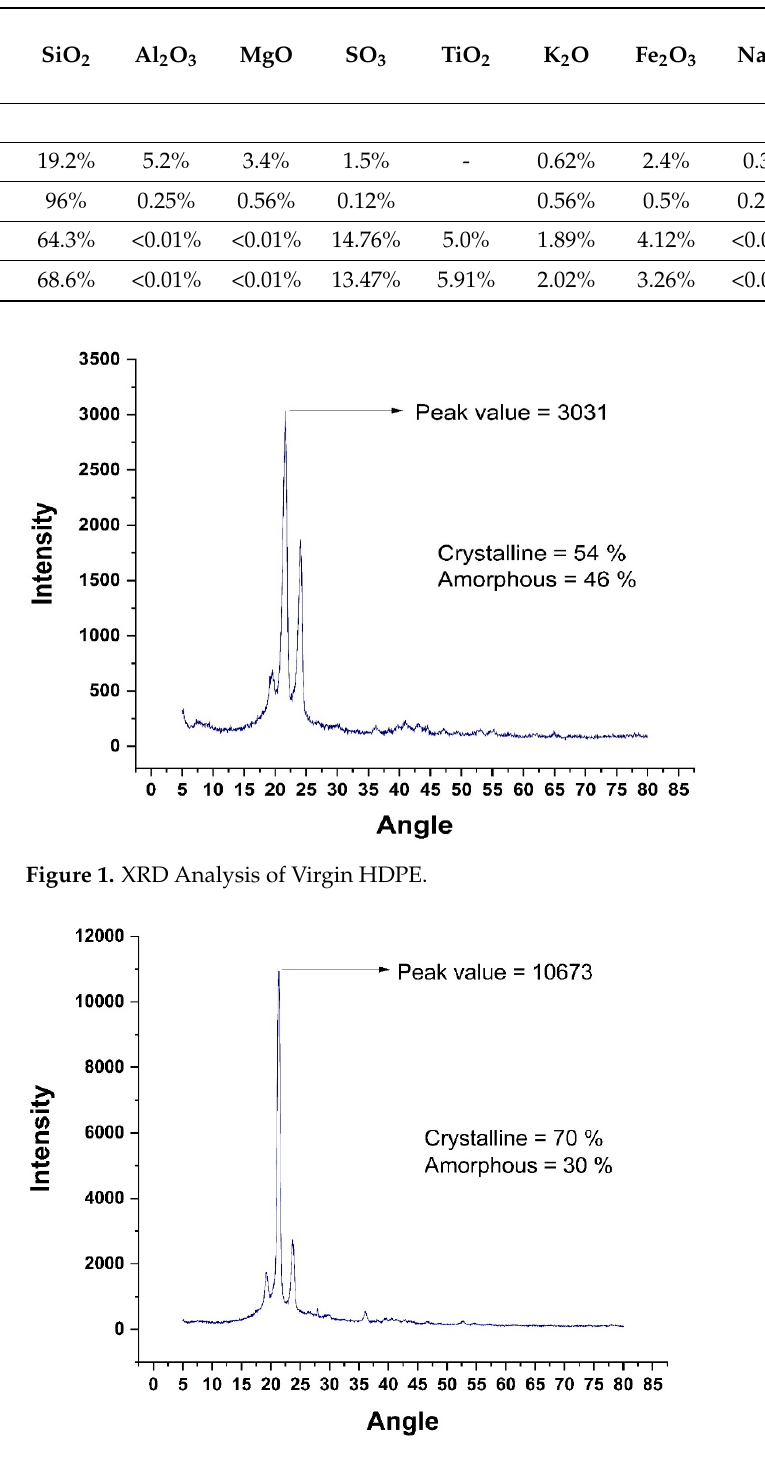
Table 2. Chemical composition of constituents of plastic concrete.